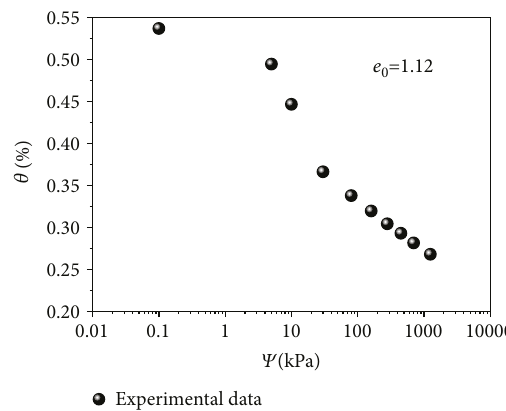
Figure 1: Measured SWCC for Hunan clay ( e